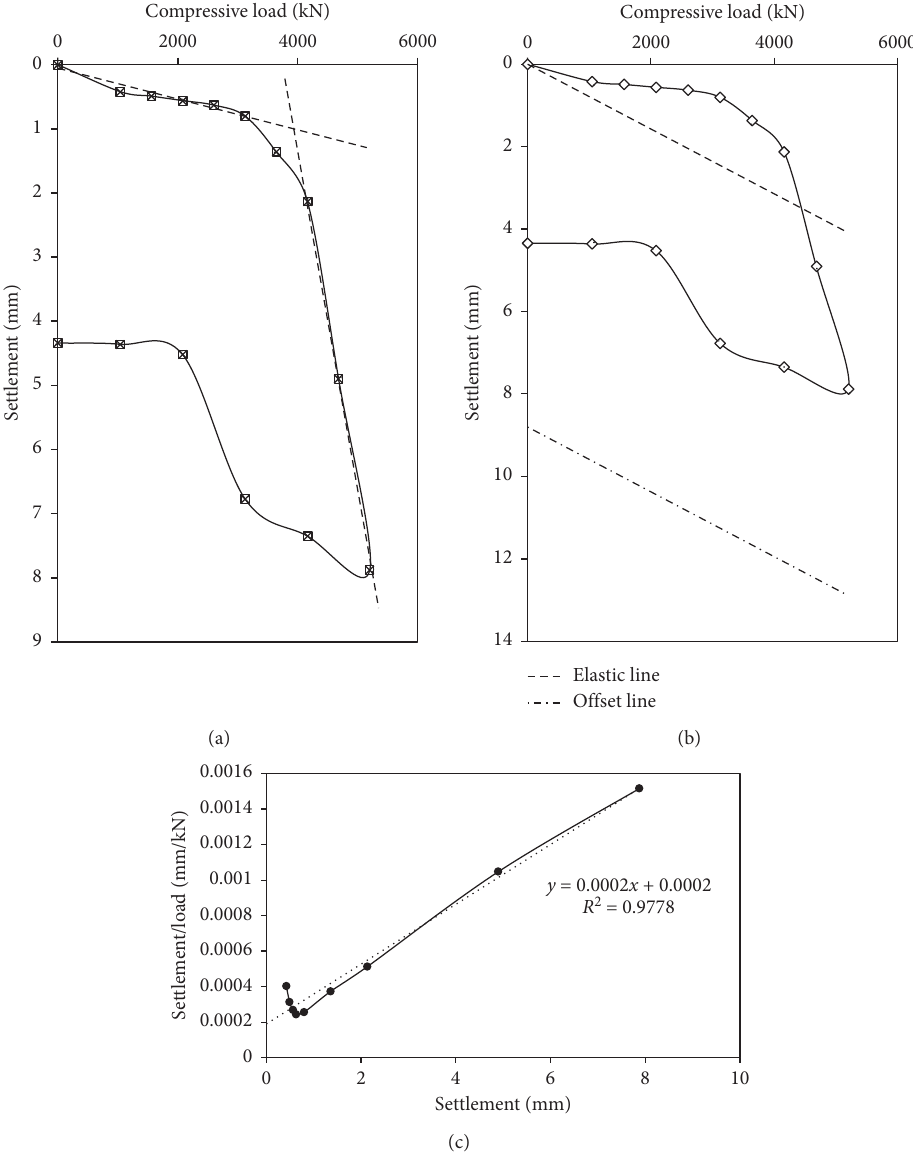
Figure 12: Interpretations of (a) double tangent method; (b) Davisson’s offset method; and (c) Chin’s